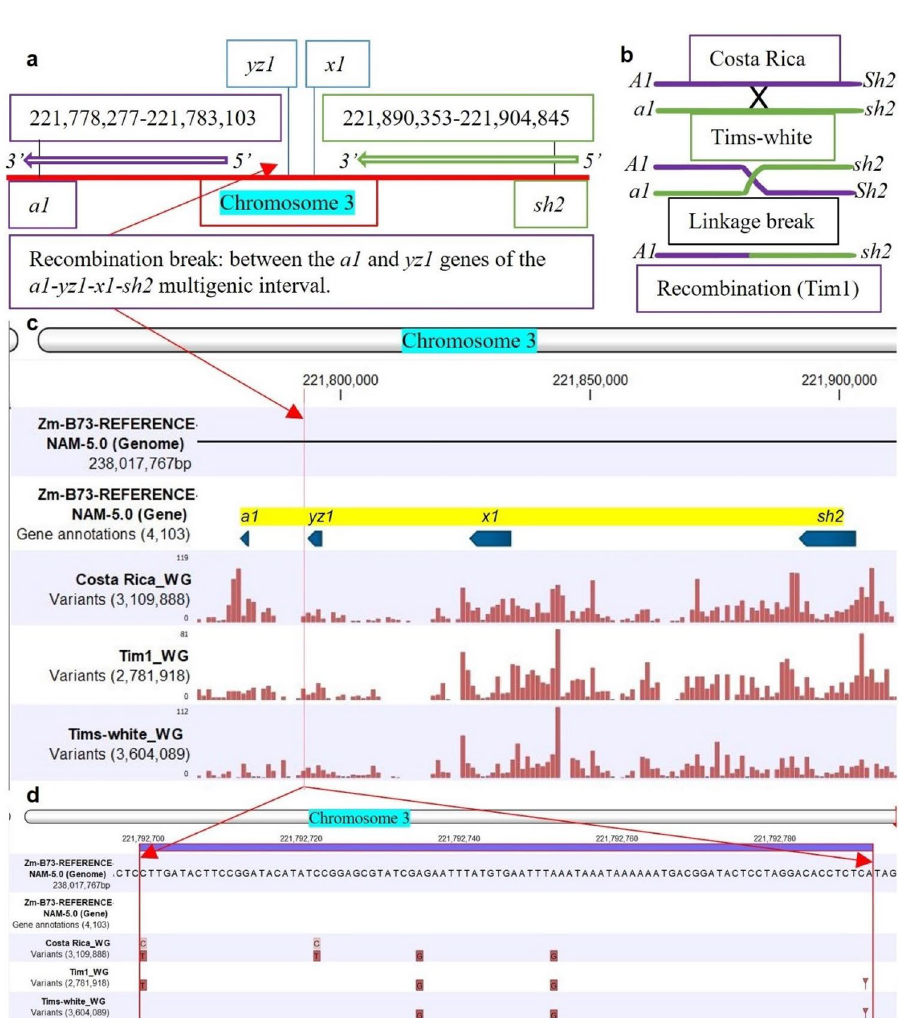
Figure 3. Linkage break and recombination: (a) length of a1 and sh2 genes on chromosome 3, along with the position of yz1 and x1 genes; ( b) linkage and recombination between A1 and sh2 alleles; ( c) mapping of the whole genome (WG) of ‘Costa Rica, ‘Tim1’ and ‘Tims-white’ lines against the reference B73 genome, with four genes (a1, yz1, x1 and sh2 ) within the a1-sh2 interval annotated (blue arrow), red bar indicates variants, with height of bar meaning read coverage; ( d) red arrows showing putative linkage break and recombination site between a1 and sh2 genes of the developed F6 line,